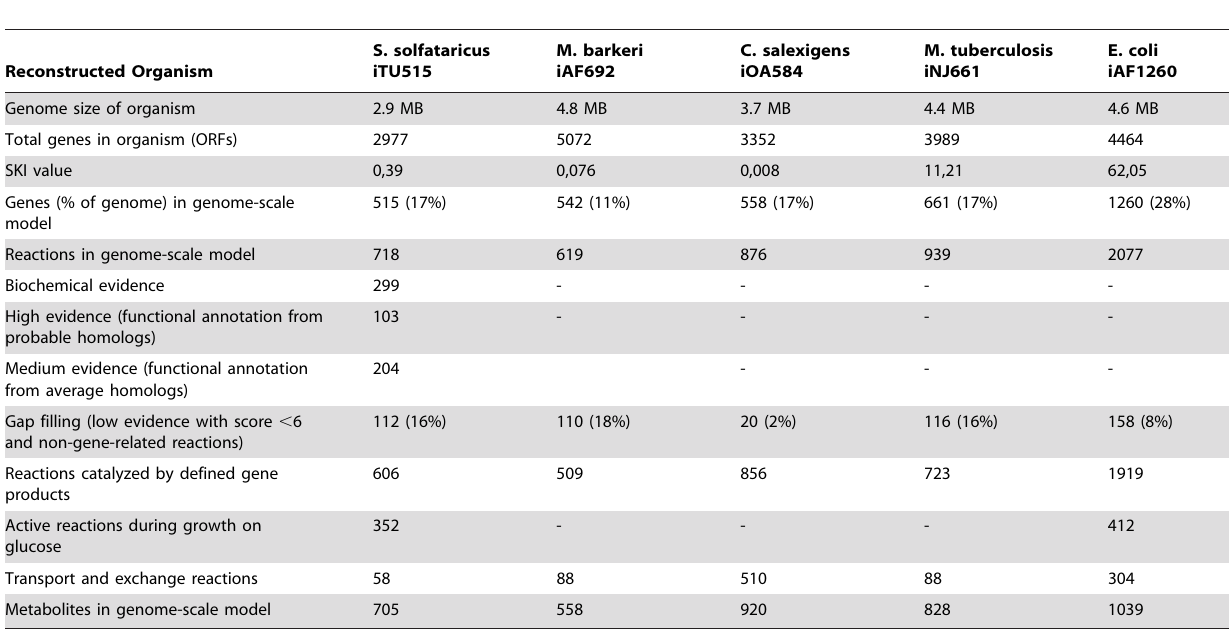
Table 1. Comparison of the properties of the metabolic reconstructions of S. solfataricus , M. barkeri , C. salexigens , M. tuberculosis , and E. coli